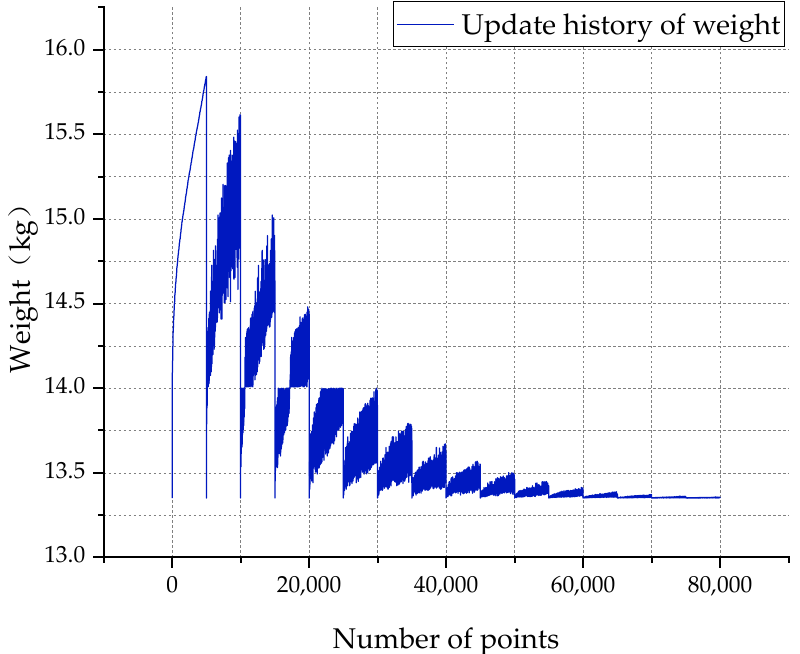
Figure 24. The iterative process of parameter “e”.